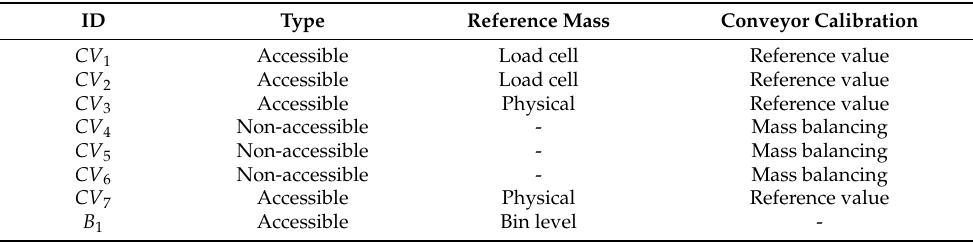
Table 2. Mass measuring units in the crushing plant.